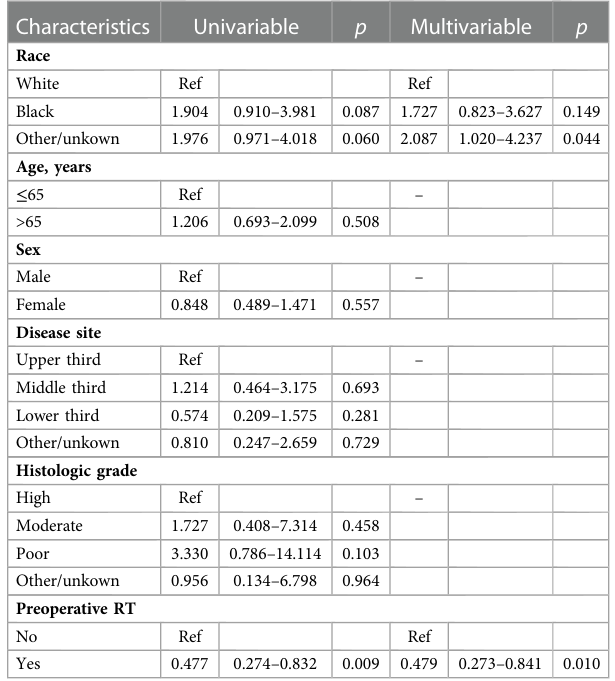
TABLE 5 Univariable and multivariable cox analysis of the in fl uence of each characteristic on postoperative survival for cT3-4 patients after propensity score